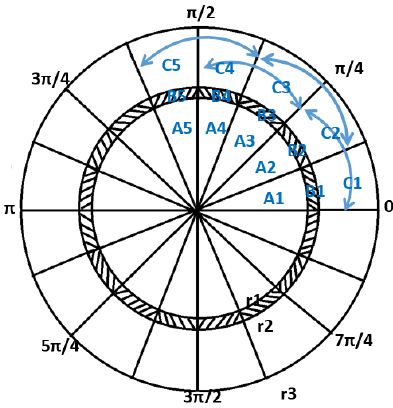
Figure 8. Sector decomposition diagram for manhole maintenance analysis.